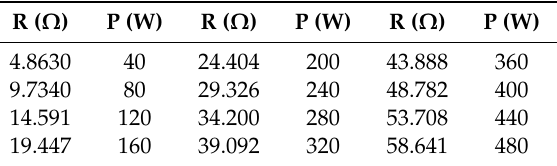
Table 3. Possible values for the resistive load.